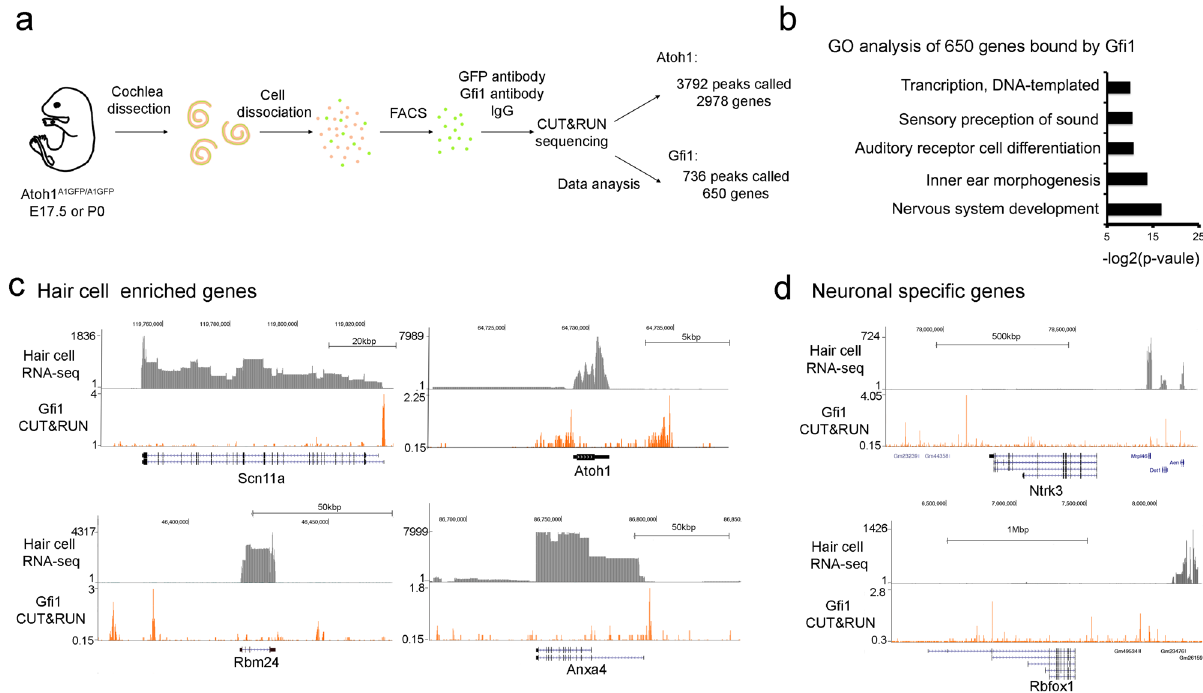
Figure 2. GFI1 directly binds to many genomic loci that it positively or negatively regulates. ( a ) Diagram of the CUT&RUN sequencing experiment. Cochleas from Atoh1 A1GFP mice in which the hair cell transcription factor ATOH1 is fused to GFP were dissected, dissociated into single cells and FACS-sorted. Purified hair cells were processed for CUT&RUN sequencing with antibodies to either GFP (to identify ATOH1 targets), GFI1, or an IgG control. ( b ) Gene ontology analysis of the 650 GFI1 binding genes. ( c ) Genomic browser track of CUT&RUN sequencing showing examples of GFI1 binding to loci near four hair cell genes: Scn11a, Atoh1, Rbm24, and Anxa4 . With the exception of Atoh1 , they are all downregulated in the Gfi1 knockout cochlea 30 . ( d ) Genomic browser track of CUT&RUN sequencing showing examples of GFI1 binding loci near known neuronal-specific genes, Ntrk3 and Rbfox that are upregulated in the Gfi1 knockout cochlea 30 . As shown in the RNA-seq traces, these two genes are normally not expressed in the neonatal hair cells, so the trace scale is expanded in both cases to show RNA-seq traces from nearby genes as a positive ment for GO terms associated with nervous system development (GO:0007399; p = 8.30E−06), inner ear mor- phogenesis (GO:0042472; p = 6.82E−05) and auditory receptor cell differentiation (GO:0042491; p = 5.30E−04; Fig. 2b). Examples of loci where GFI1 is bound in hair cells are shown in Fig. 2c. Examples of neuronal genes that are bound directly and repressed by GFI1 are shown in Fig. 2d. To determine which hair cell genes are either directly repressed or activated by GFI1 during hair cell develop- ment, we compared our GFI1 CUT&RUN data with the hair cell genes that were up-or down-regulated in Gfi1 knockout mice. We found GFI1 bound to 51 hair cell genes that were downregulated in the Gfi1 knockout (i.e., positively regulated by GFI1) and 8 hair cell-enriched genes that were upregulated in the Gfi1 knockout (i.e., neg- atively regulated by GFI1; Supplementary Table S3). These results suggest that GFI1 can function to both directly activate and directly repress hair cell genes. To identify which transcription factors GFI1 might be co-operating with in hair cells, we performed a de novo motif analysis on the 736 GFI1 peaks from our CUT&RUN analysis. A number of motifs for families of transcription factors associated with hair cell development were enriched in the peaks, including motifs for SIX family proteins (p-value = 1E−51), POU family proteins (p-value = 1E−31) and bHLH family proteins (p-value = 1E−20; Fig. 3a). Although motifs for zinc-finger transcription factor family proteins (of which GFI1 is a member) were enriched in the peaks, their enrichment was significantly lower than for the other transcription factor families described above (p-value = 1e−16). GFI1 positively regulates hair cells genes by binding with ATOH1 at the same genomic loci. In Drosophila , the GFI1 homolog Senseless acts as a positive co-regulator of gene expression in concert with proneural transcriptional factors such as the Atoh1 homolog atonal 20 . However, it has not been established whether mammalian GFI1 and ATOH1 interact together in cochlear hair cell development. When we performed a known motif analysis for bHLH transcription factor sites on peaks that were bound by GFI1, we found that the “AtEAM” sequence motif associated with ATOH1 43 is enriched in the GFI1-bound peaks (p-value = 1E−11; Supplementary Fig. 2). To confirm if GFI1 interacts with ATOH1 in vivo, we first examined whether they can be localized to similar genomic sites in hair cells. We identified direct targets of ATOH1 in purified hair cells using CUT&RUN (Figs. 2a, 3c). We identified 3792 ATOH1-bound peaks using MACS2 (Fig. 3b, Supplemen- tary Table S2 Sheet 2). 386 out of the 736 GFI1-bound peaks overlapped with ATOH1 bound peaks (Fig. 3b,c,